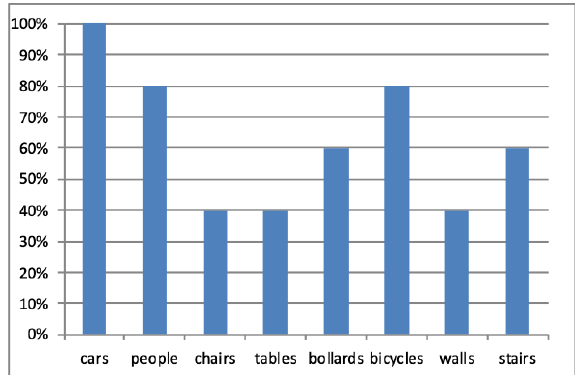
Figure 4. Users’ preferences for the objects’ types they would like to have